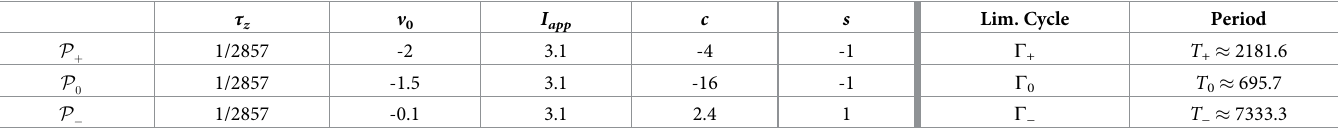
, the system will display a limit cycle Γ i